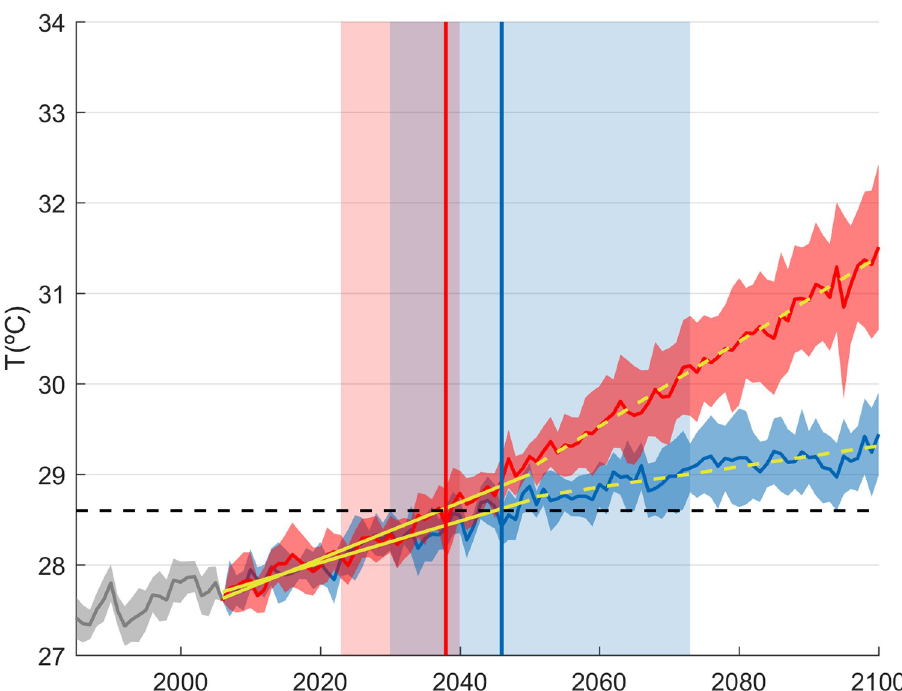
Fig 9. Historical (grey) and future projection of the Red Sea SST basin average (in ˚C) under scenario RCP 8.5 (red) and scenario RCP4.5 (blue). The solid lines indicate the ensemble average while the patch represents the range of values from the ensemble. Yellow lines indicates a linear trend fitted for both scenarios for the period 2006–2050 (solid lines) and 2051–2100 (dashed lines). The vertical boxes indicate the time period when the global temperature would be 1.5˚C above preindustrial levels in both